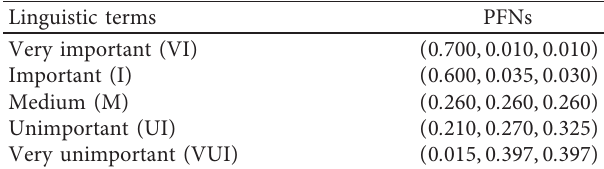
Table 13: Importance weight as linguistic variable.